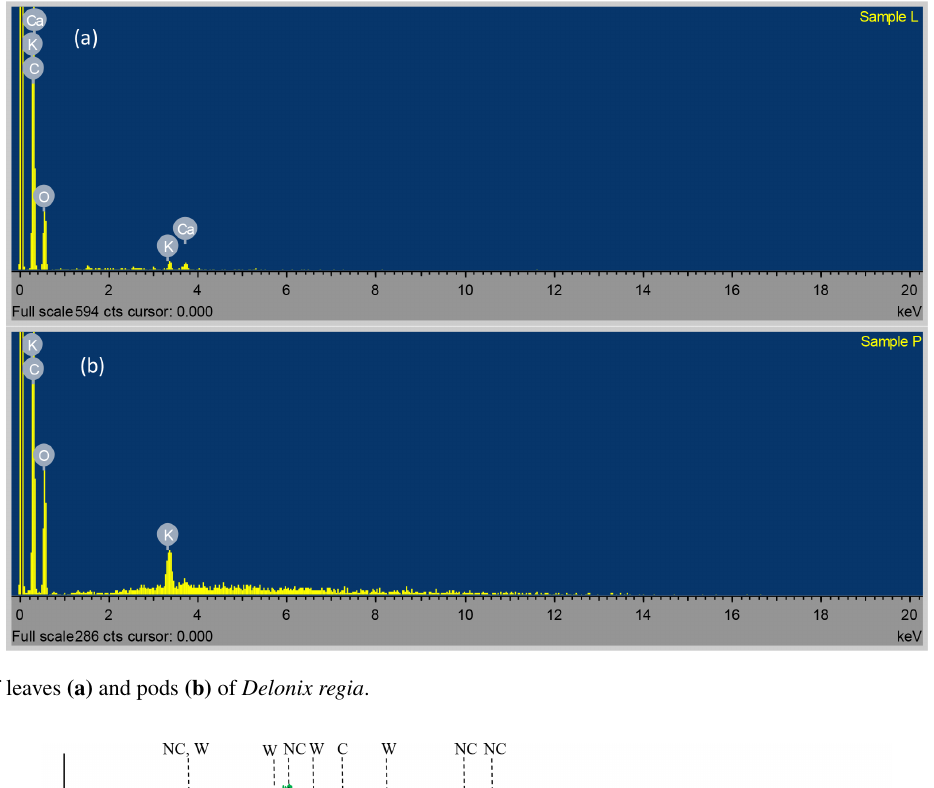
Figure 2. EDS of leaves (a) and pods (b) of Delonix regia .